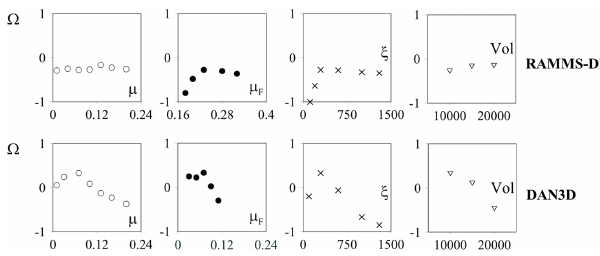
Figure 5. Sensitivity of the dimensionless (cid:127) value (Eq. 7) to µ , µ ξ and the initial volume for the Gesäuse case study for both simu- lation models. While varying one parameter, the other parameters were kept